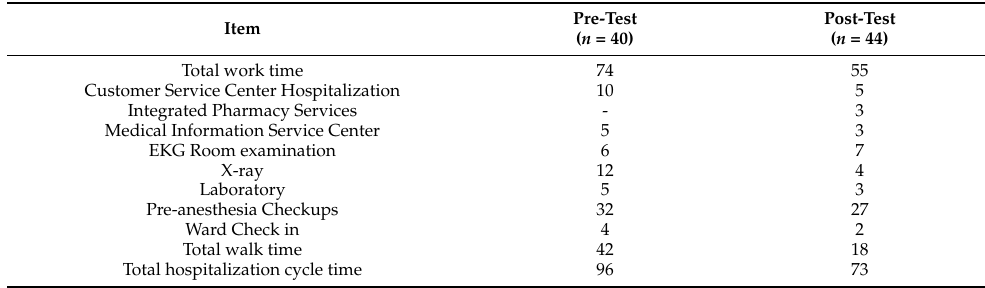
Table 5. The average time for patients to complete the hospitalization procedure after hardware